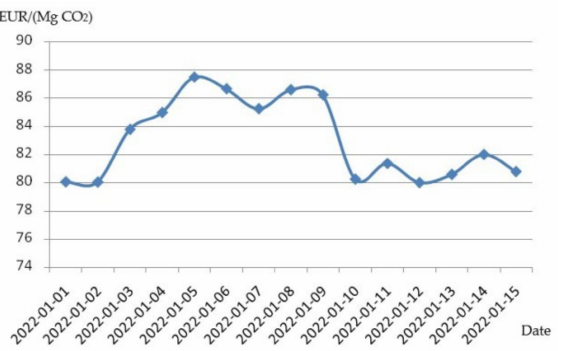
Figure 2. Settlement price of CO 2 emission allowances (Source: own work based on data from [17]). The volume-weighted average price on the DAM Day-Ahead Market in May 2021 was at the level of PLN 300.62/(MW · h) (approx. EUR 65/(MW · h)), and this is an increase by PLN 24.42/(MW · h) compared to the previous month and the first case in the history of the Polish Power Exchange (TGE) when the monthly price of the DAM exceeds PLN 300/(MW · h). But the average price weighted by the trading volume on the DAM was formed in November 2021 at the level of PLN 552.40/(MW · h) (approx. EUR 120/(MW · h). The pattern of the electricity price and sales volume for the selected day is presented in Figure 3.